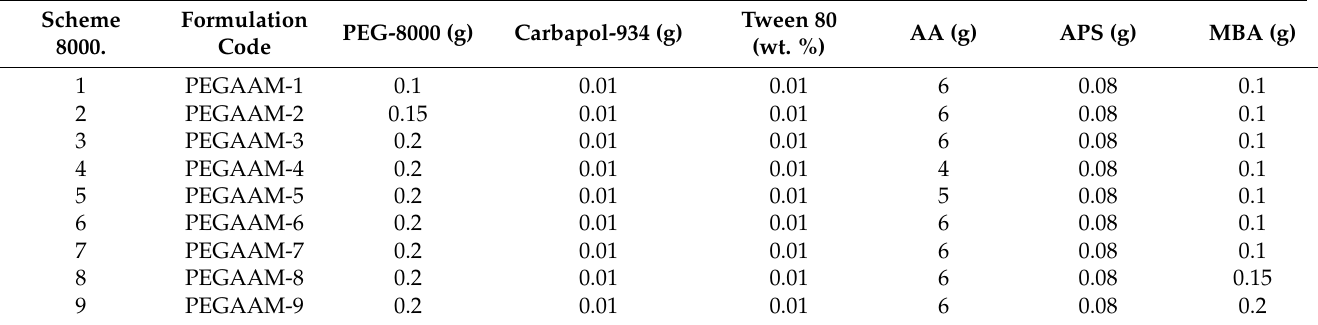
Table 1. Composition of fabricated PEGAAM